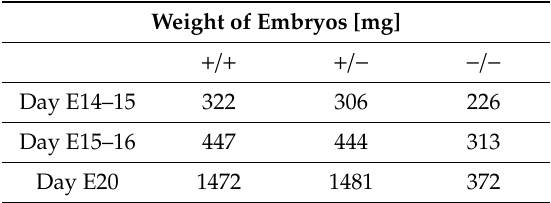
Table 3. Weight of embryos in mg directly after dissection at three di ff erent embryonal ages. n